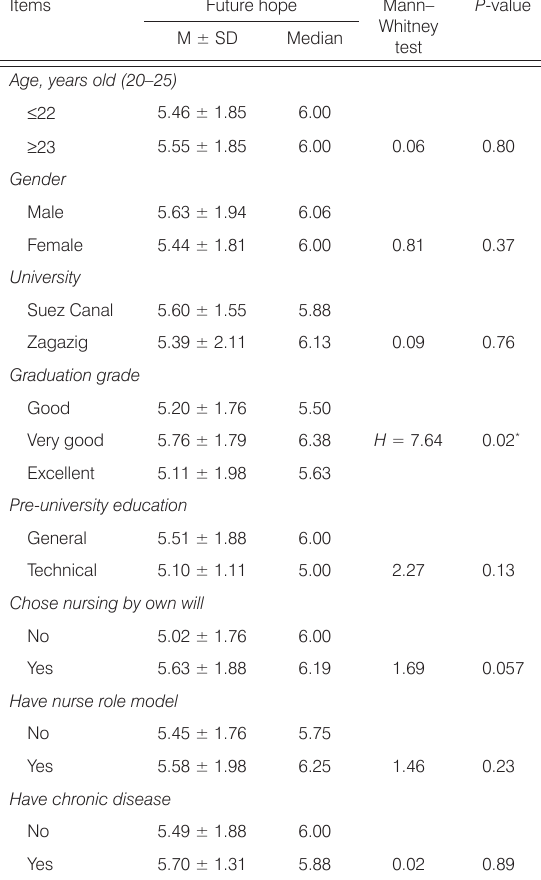
Table 5. Relations between nurse interns’ future hope scores and their personal characteristics.